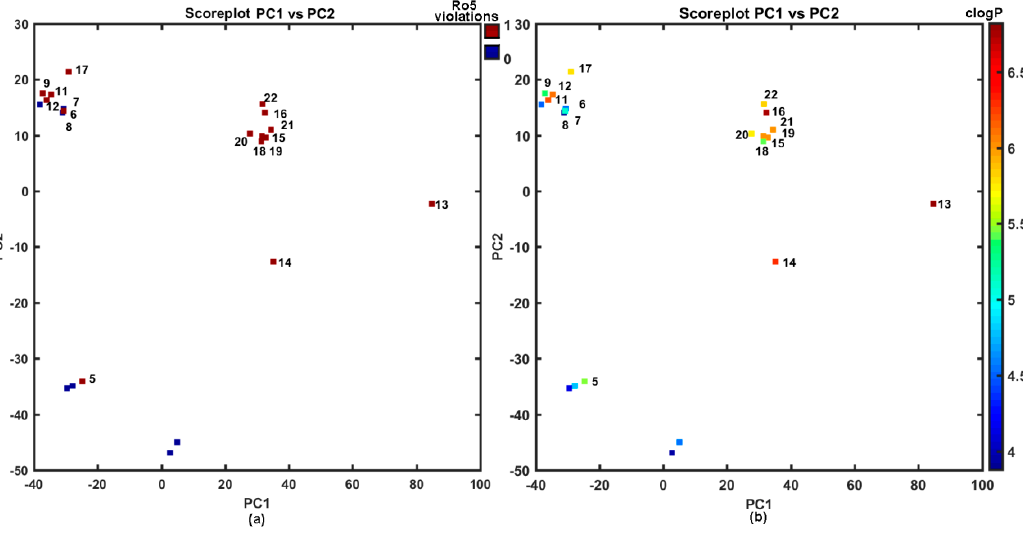
Figure 2. Projection of carboxamides 1 – 22 on the plane defined by first vs. second principal components for Dragon descriptors with Ro5 rule violations ( a ) and calculated lipophilicity clogP ( b ) colors code numerical values of clogP and Ro5 violations. Molecules with Ro5 violation and clogP > 5 are numerically labeled.